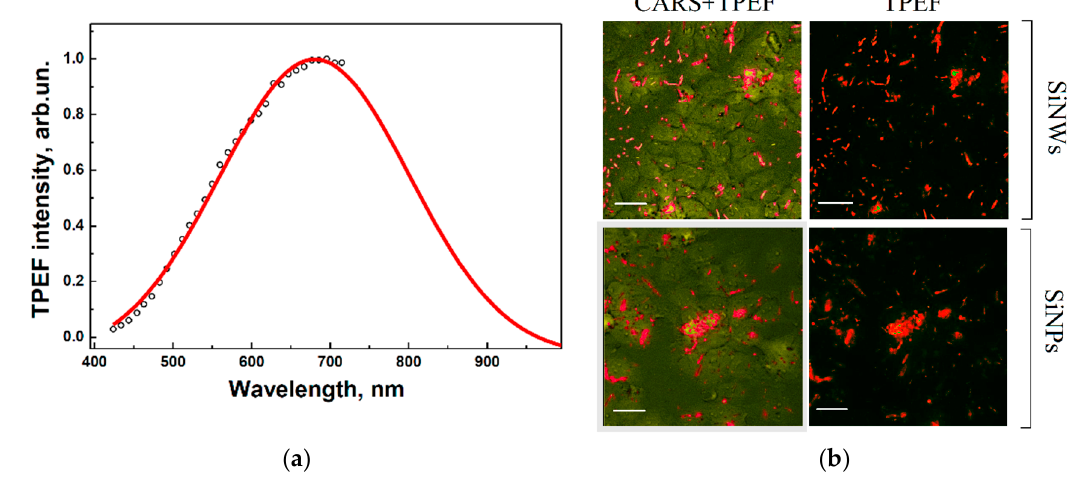
Figure 4. ( a ) Two-photon excited fluorescence (TPEF) spectrum of SiNPs; and ( b ) merged images of CARS and TPEF of SiNWs ( top ) and of SiNPs ( bottom ) in MCF-7 cells. SiNPs depicted in red within the cells depicted in green. The scale bar corresponds to 20 µm.